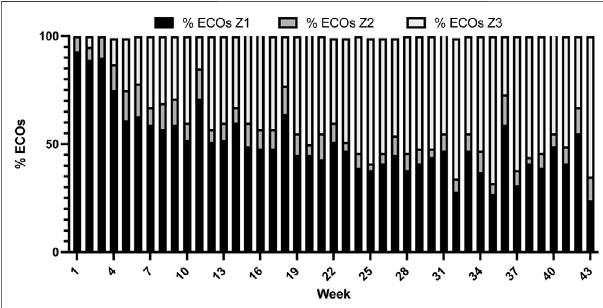
FIGURE 3 | Weekly training load distribution (ECOs distributed at triphasic